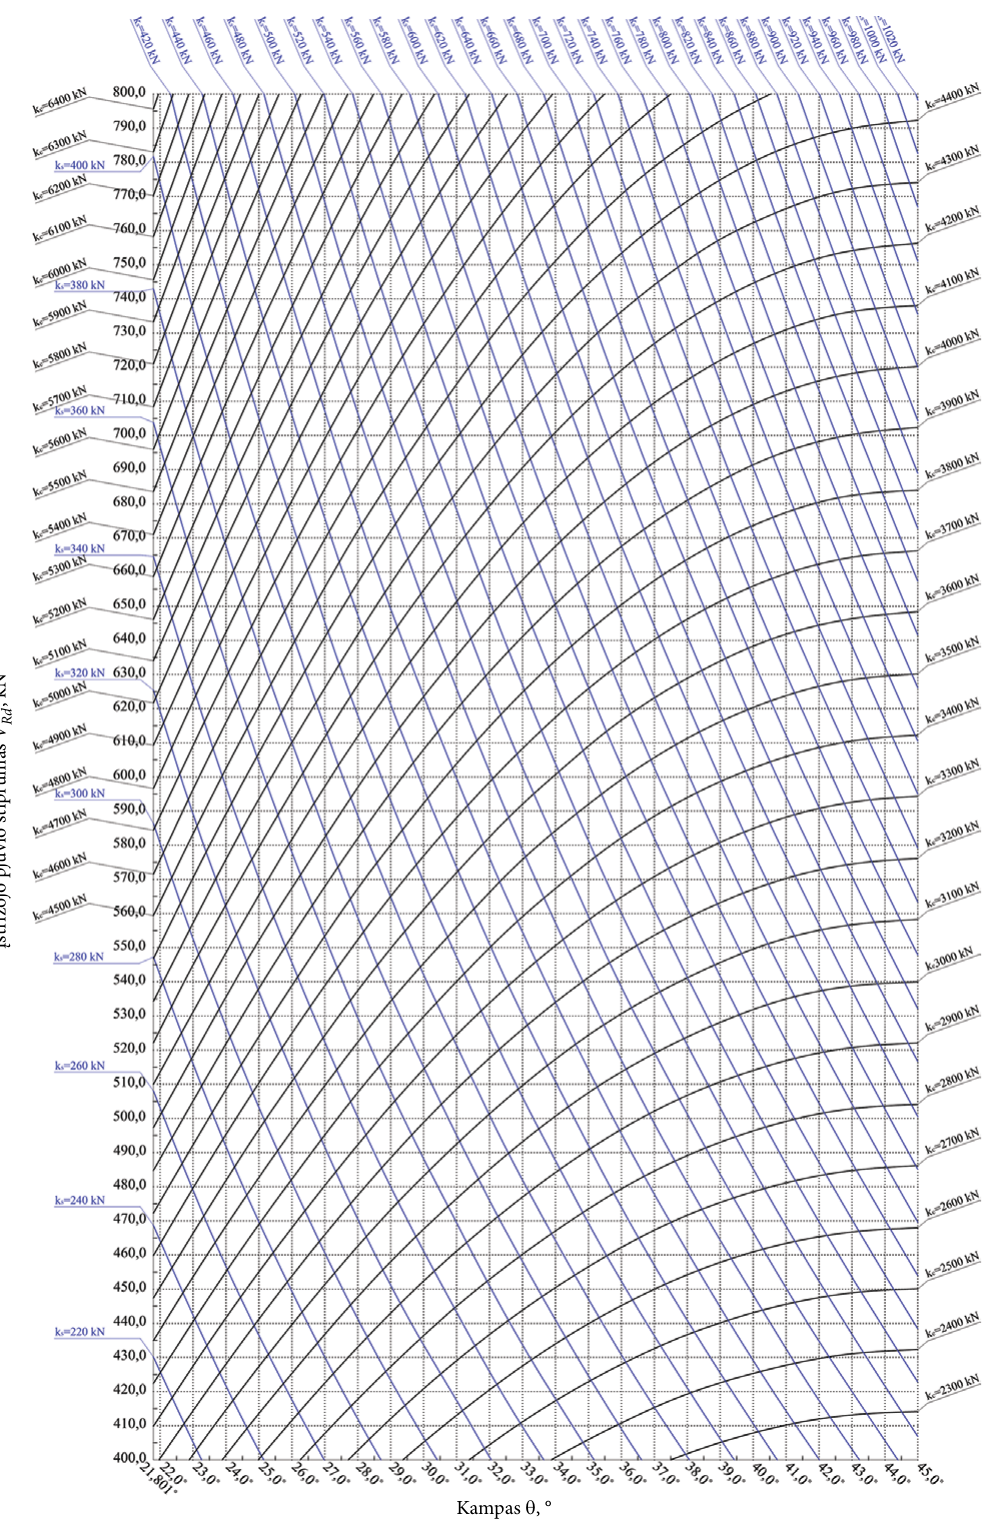
Fig. 10. The 2nd graphic of shear strength identification of bending elements with vertical shear